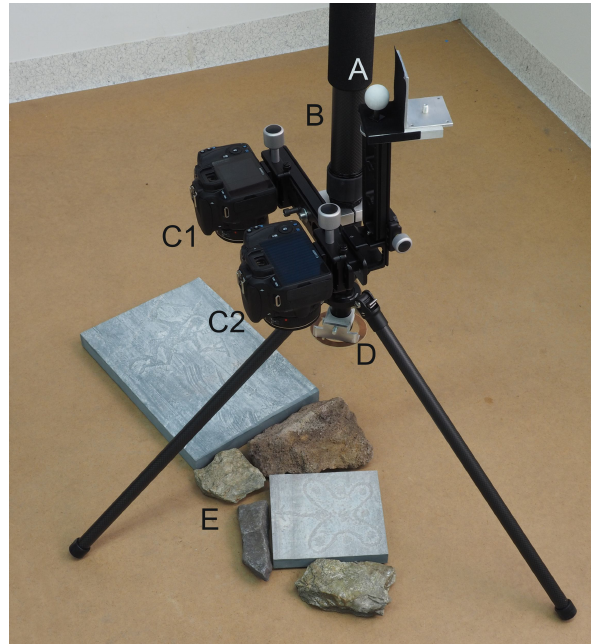
Figure 7: Scanner prototype used for data acquisition: A stereo rig containing two DSLR cameras (C1, C2) and a white sphere for outside-in tracking (A) are mounted onto a carbon fibre mount (B). A mount (D) is included to properly fix a detachable custom LED illumination component (not shown here). The scanner ob- serves the laboratory mockup consisting of a few rocks and two 3D prints